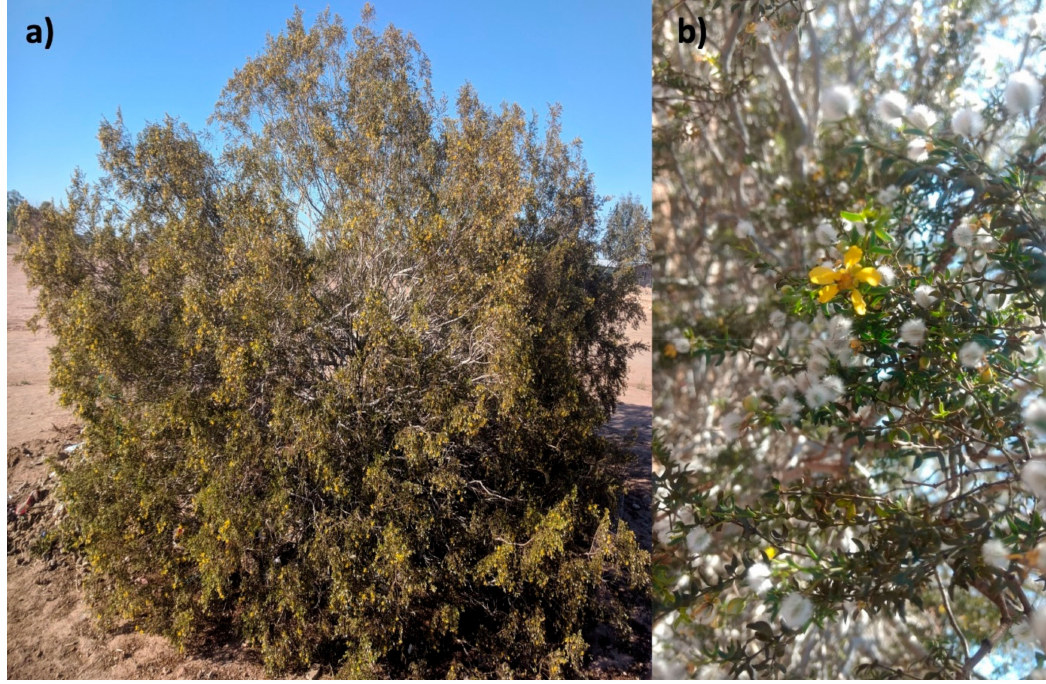
Figure 2. Larrea tridentata from Valley of Mexicali: ( a ) bush; ( b ) magnified picture of fruits, branches and flowers. (original